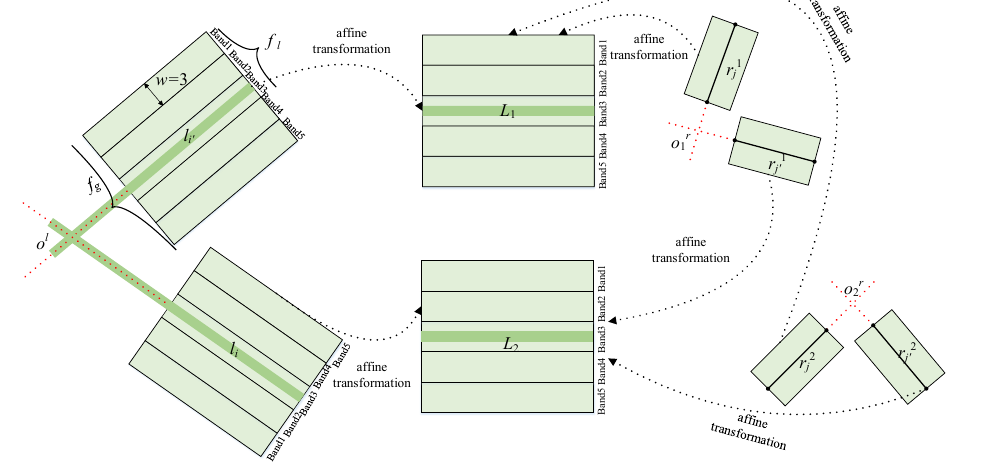
Figure 4. LBD descriptors based on the affine transformation of line-pairs